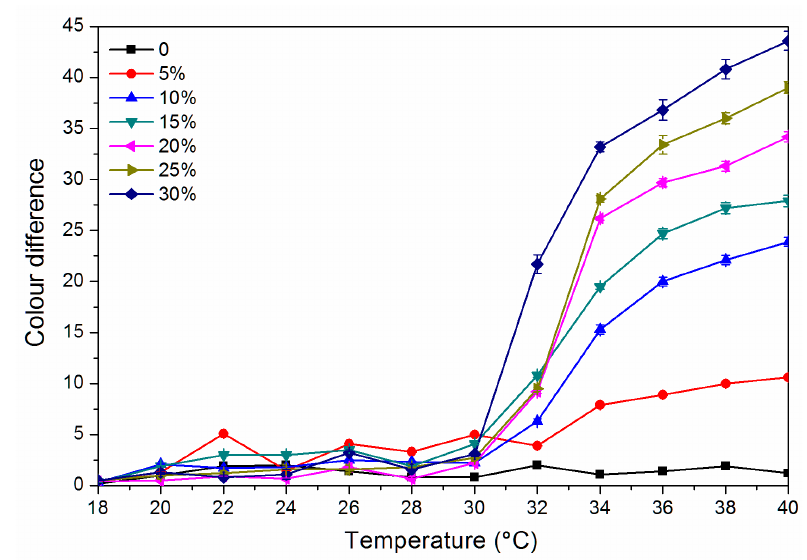
Figure 4. E ff ect of thermochromic ink concentration on colour di ff erence of waterborne finish film from Figure 4. Effect of thermochromic ink concentration on colour difference of waterborne finish film 18 to 40 ◦ C. Polymers 2020 , 12 , 552 from 18 to 40 ° C.